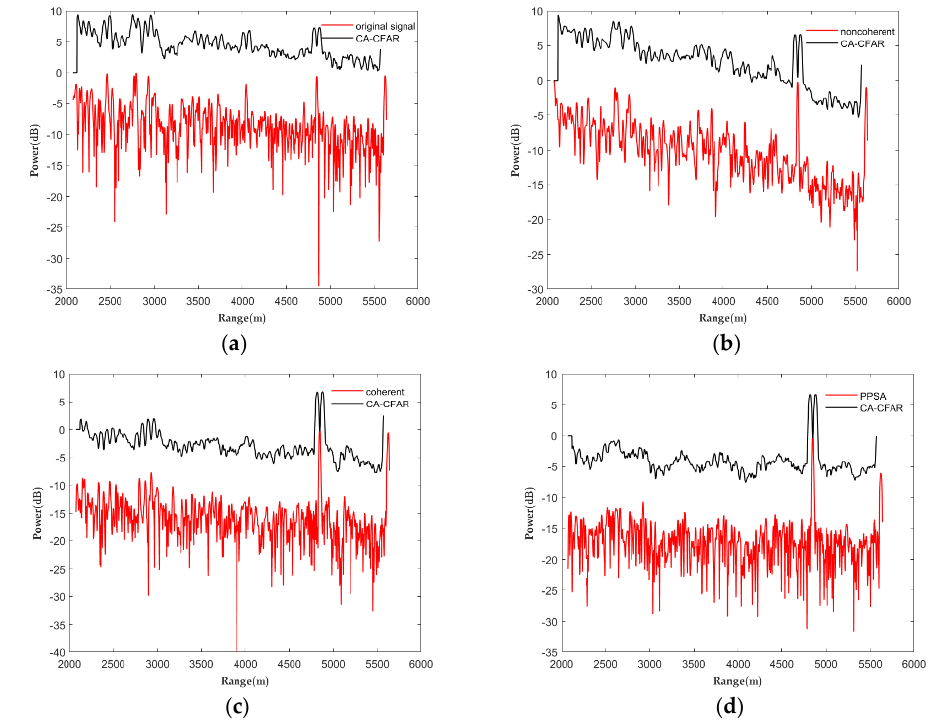
Figure 17. The CFAR detection results for PPSA. ( a ) The result of target area, ( b ) the result of nonco-